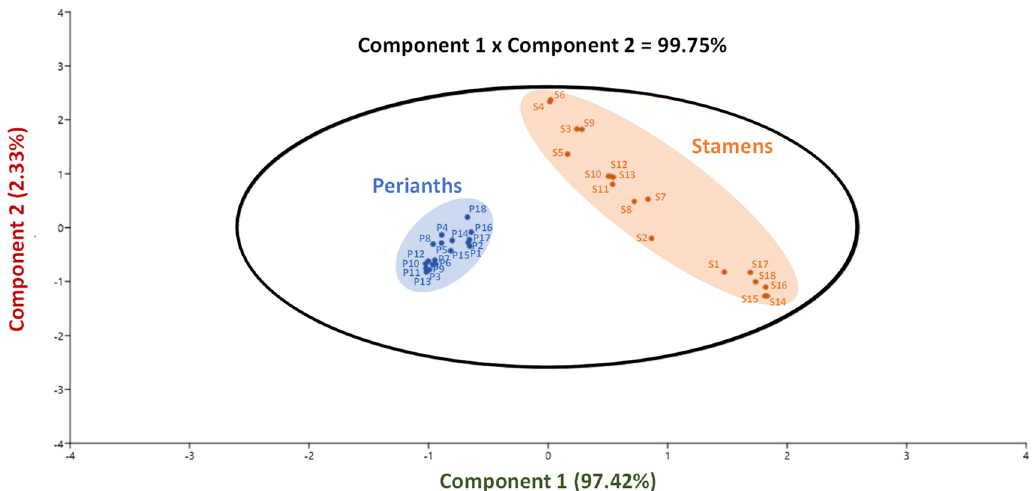
Figure 7. Principal component analysis (PCA) linking the phytochemical profile and antioxidant capacity of the stamen and perianth extracts of 18 N. nucifera populations originating from various floristic regions from Thailand. Variance of component 1 = 97.42% and component = 2.33%. S: stamen extract; P: perianth extract; each number in blue represents the different populations. The corresponding loading score plots for components 1 and 2 are presented in Figure S1. Table 4. Pearson coefficient correlation) between phytochemical profiles and antioxidant activities of the stamen and perianth extracts of 18 N. nucifera